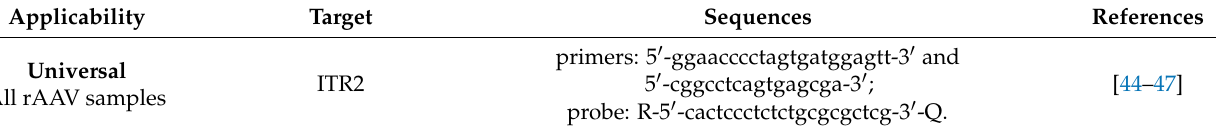
Table 1. Examples of primers and probes used for rAAV quantitative